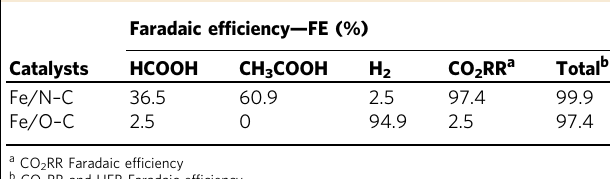
Table 1 CO 2 RR behavior of Fe/O – C and Fe/N – C samples at a fi xed voltage of − 0.5 V vs